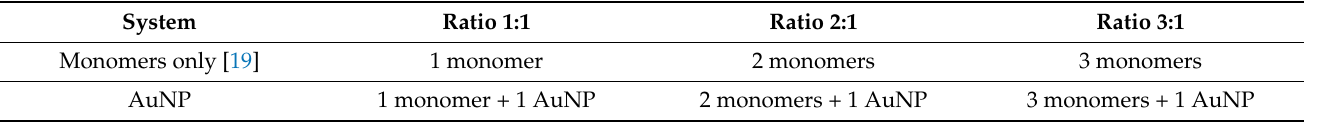
Table 1. Composition of each simulation box. AuNP: gold nanoparticles.